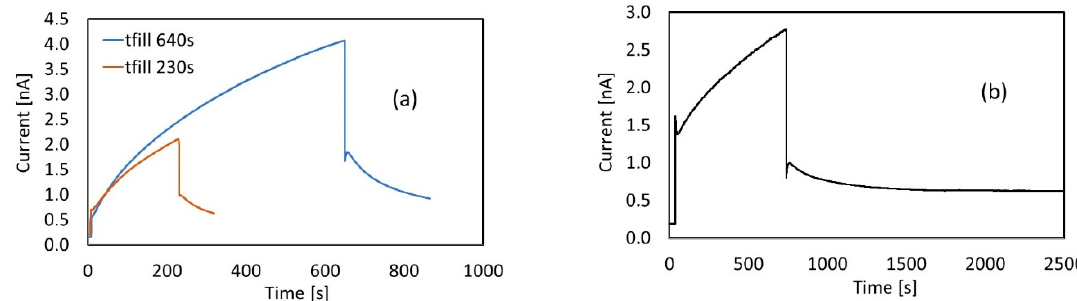
Figure 3. Photoconductivity of polycrystalline CsPbBr 3 (400 nm LED, T i = 290 K, V b = 5 V): ( a ) two priming with increasing duration; ( b ) priming process and afterward with light off, to evidence the presence of persistent currents.